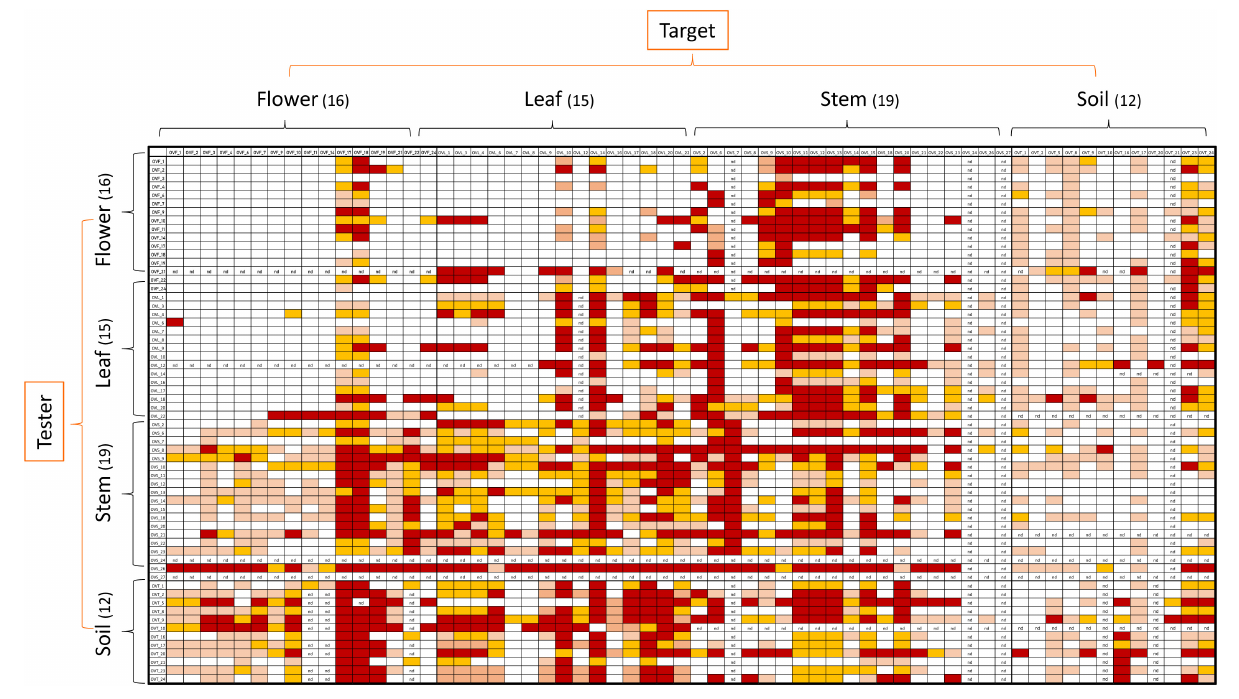
Materials and Methods. To this purpose, each strain was used either as a tester or target. The antagonistic effect was indicated by the absence or reduction of the target strain growth.